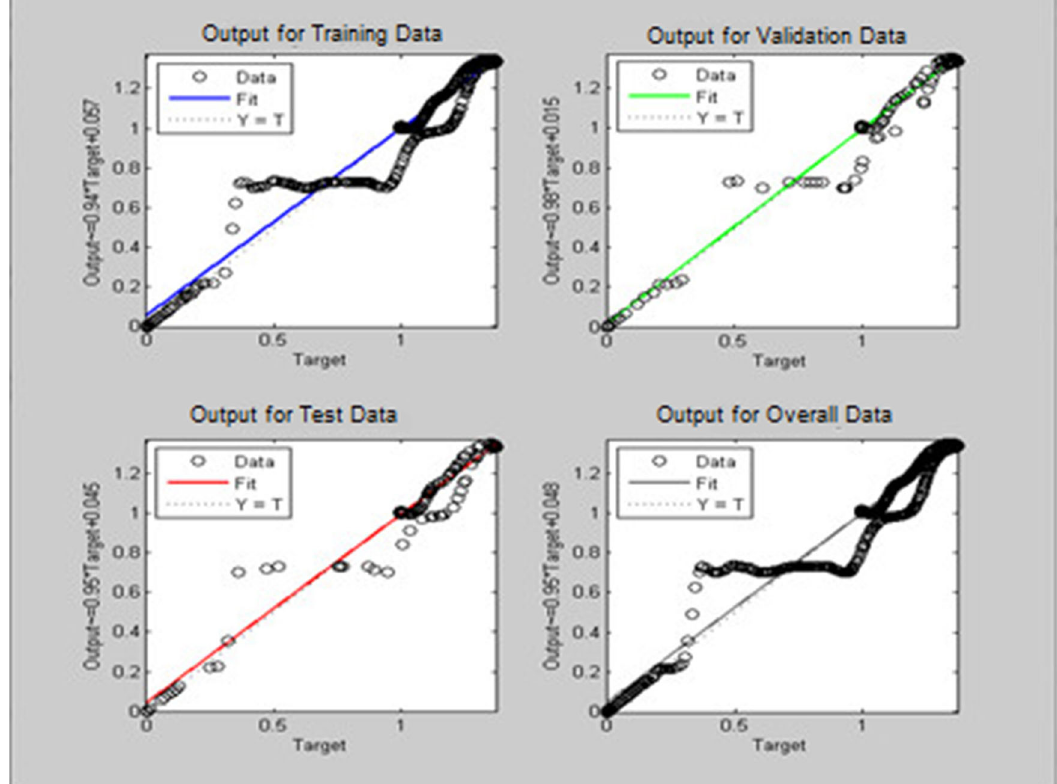
Figure 8. Neural network regression graph for the yaw system.